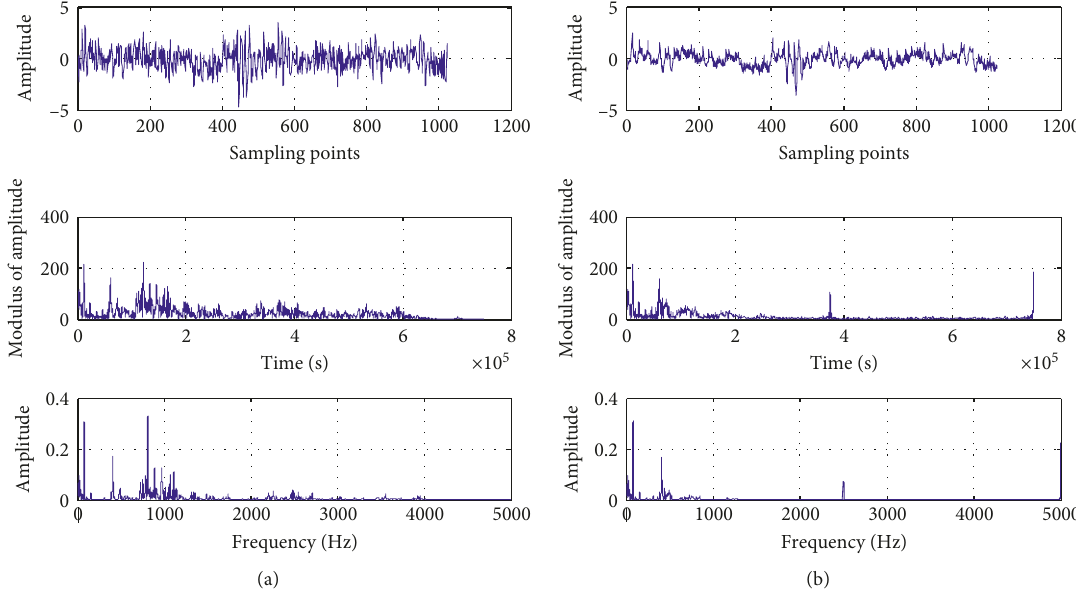
Figure 17: (a) Inner wear signal, inner wear Fourier transform, and power spectral density plot; (b) denoising signal, Fourier transform, and power spectral density plot after improving threshold.